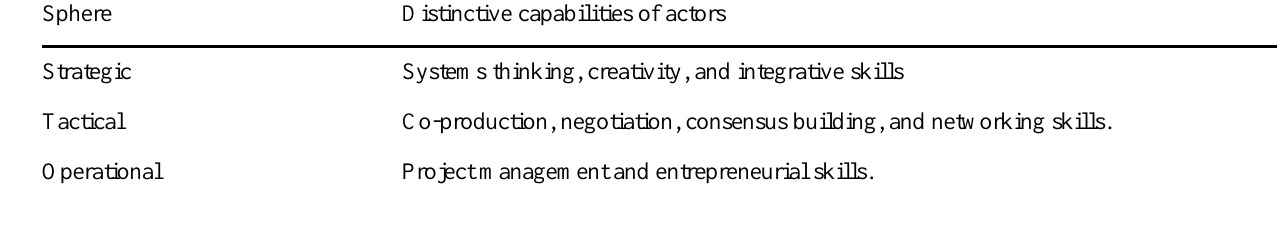
Table 3. Distinctive capabilities of actors for each TM sphere (based on Loorbach 2004). Note that some capabilities, such as communication learning and leadership skills are present in all spheres, see Loorbach (2007) for complete